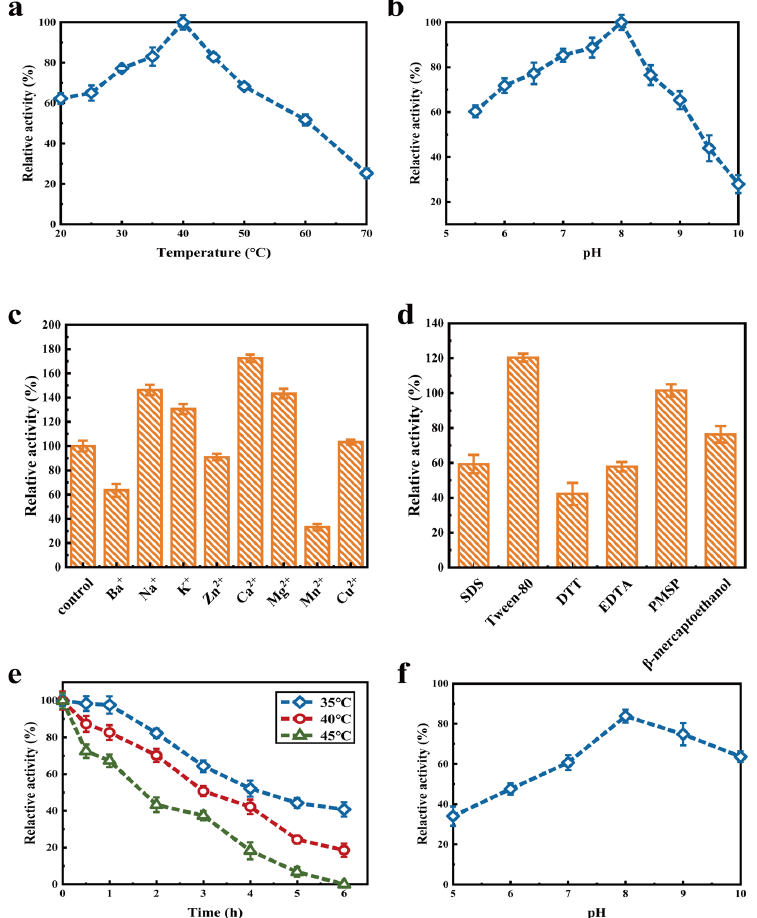
Figure 3. Enzymatic properties of κ -selenocarrageenase: effects of temperature ( a ), pH ( b ), metal ions ( c ), and chemical additives ( d ); its thermal stability ( e ) and pH stability ( f ).